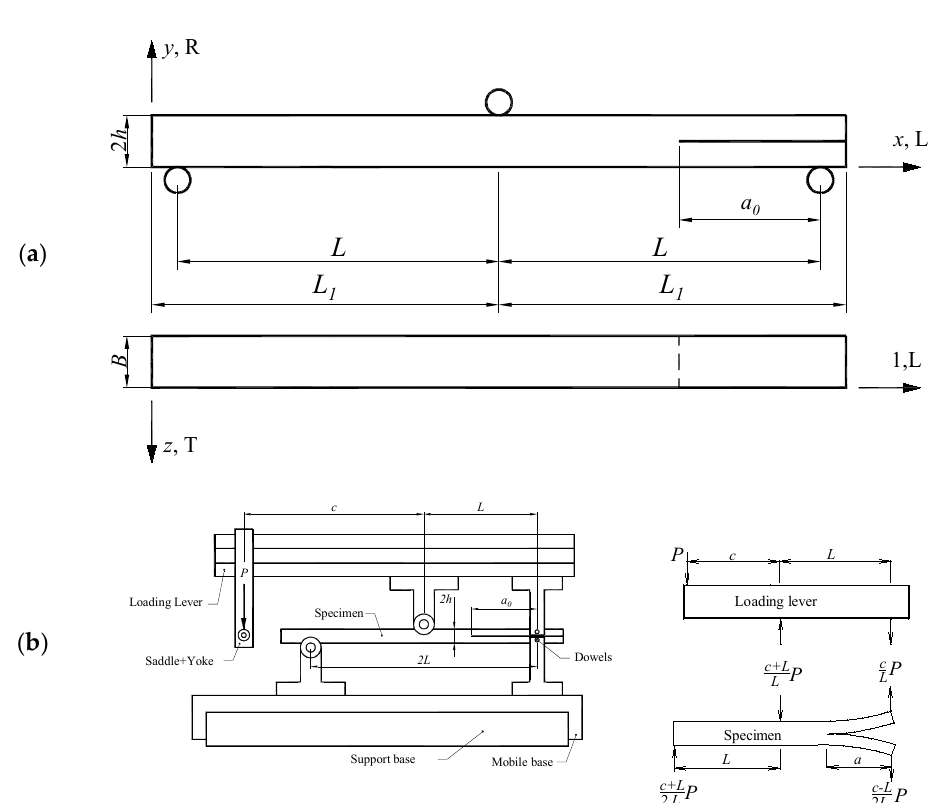
Figure 1. Mixed mode bending (MMB) test: ( a ) specimen geometry (2 h = 20 mm, L = 230 mm, L 1 = 250 mm, a 0 = 162 mm and B = 20 mm); ( b ) set-up and free-body diagrams ( P —applied load).